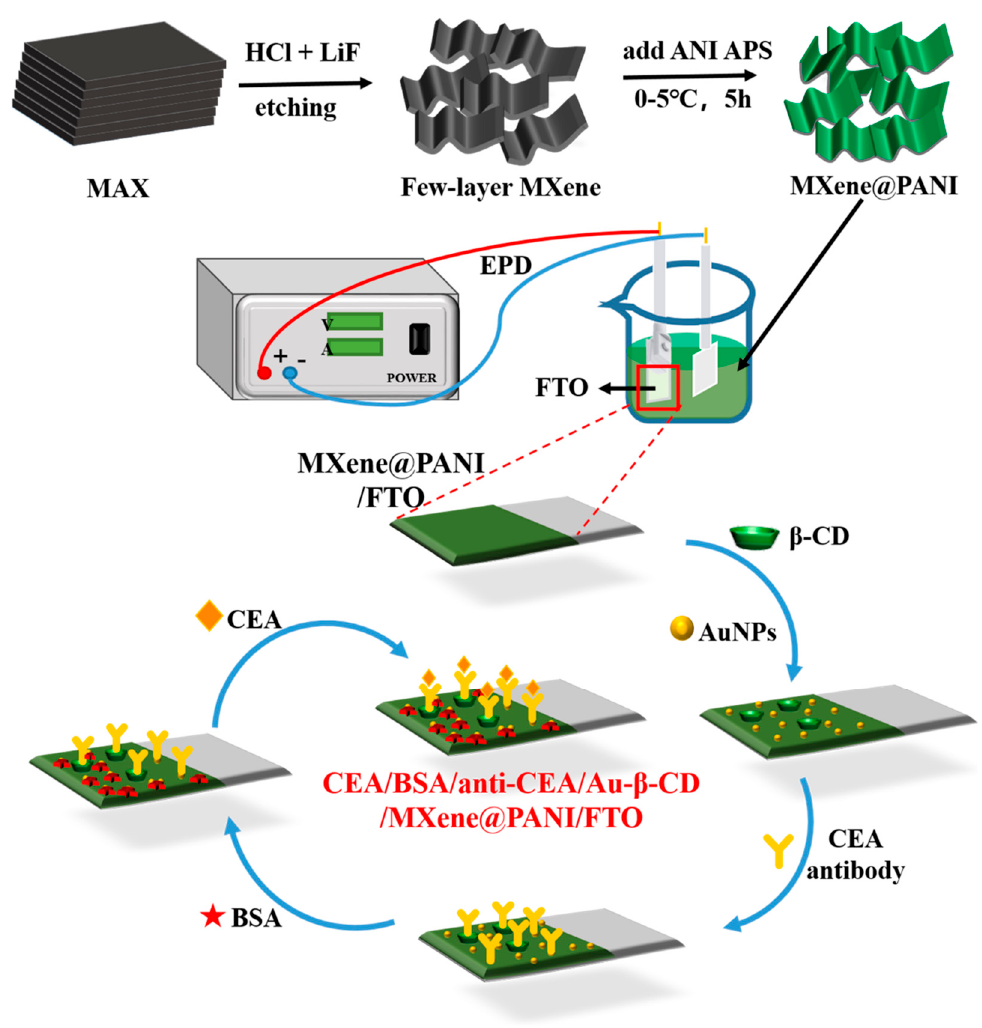
Scheme 1. Schematic diagram of the electrochemical immunosensor fabrication steps for label-free detection of CEA.